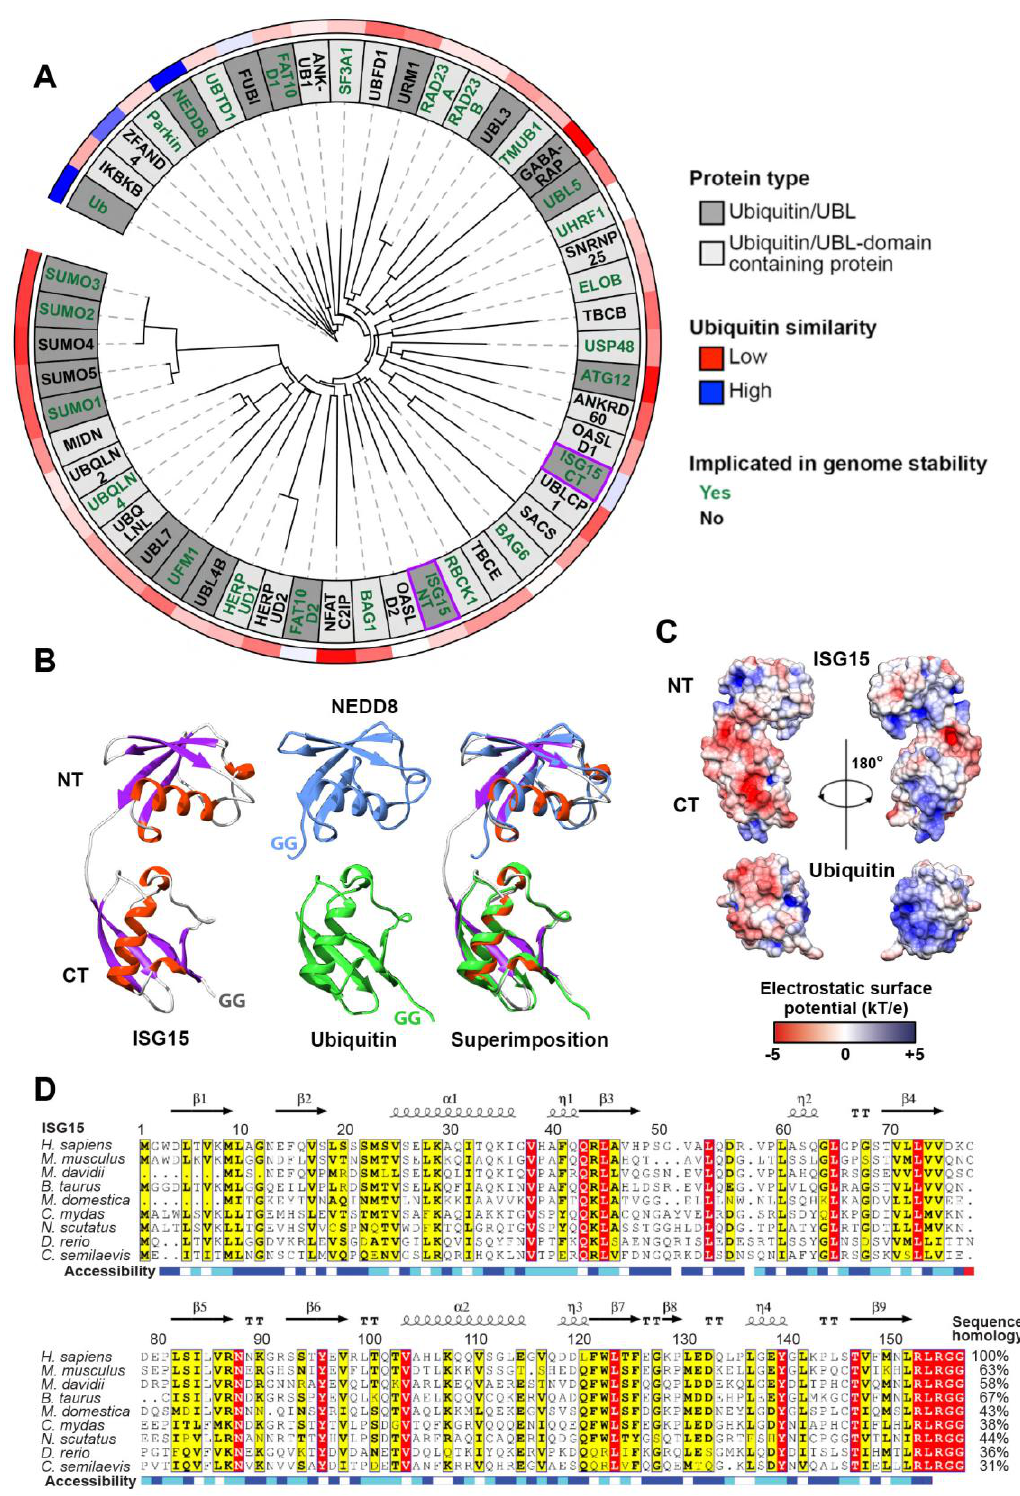
Figure 1. ISG15 comparison with selected ubiquitin / UBLs, ubiquitin-like domains and across species. ( A ) Phylogeny of ubiquitin (Ub), ubiquitin-like proteins (UBLs) and Ub / UBL domains fused to human proteins. Genome stability associations are highlighted in green and apply to the following in addition to ISG15: Ub [3,10], Parkin [47–50], NEDD8 [11], UBTD1 [51], FAT10 [12], SF3A1 [52], RAD23A and RAD23B [53], TMUB1 (aka HOPS) [54–56], UBL5 (aka HUB1) [12], UHRF1 [57–59], ELOB (aka TCEB2) [60], USP48 [61,62], ATG12 [63], BAG6 [64], RBCK1 [65], BAG1 [66,67], HERPUD1 [68], UFM1 [12], UBQLN4 [69], SUMO1, SUMO2 and SUMO3 [70]; sequence similarity to ubiquitin highlighted in the outermost ring ranging from GABARAP (9.59%) in red over a white midpoint to